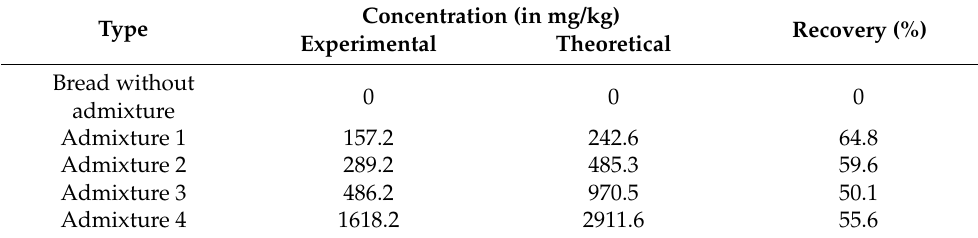
Table 3. The theoretical and experimental concentration expressed in mg/kg as well as the recovery values (%) of sorbic acid in bread samples.